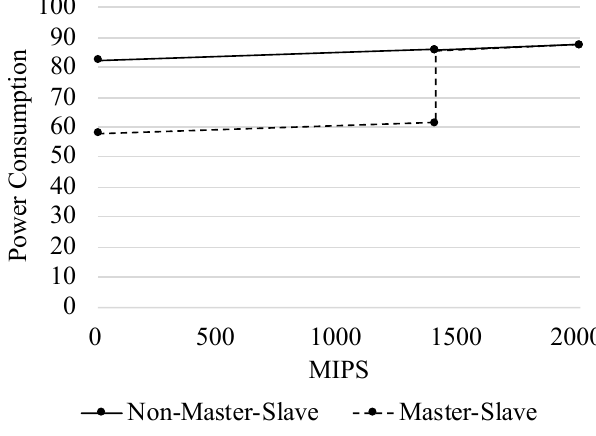
Figure 3. Power consumption of the device in different